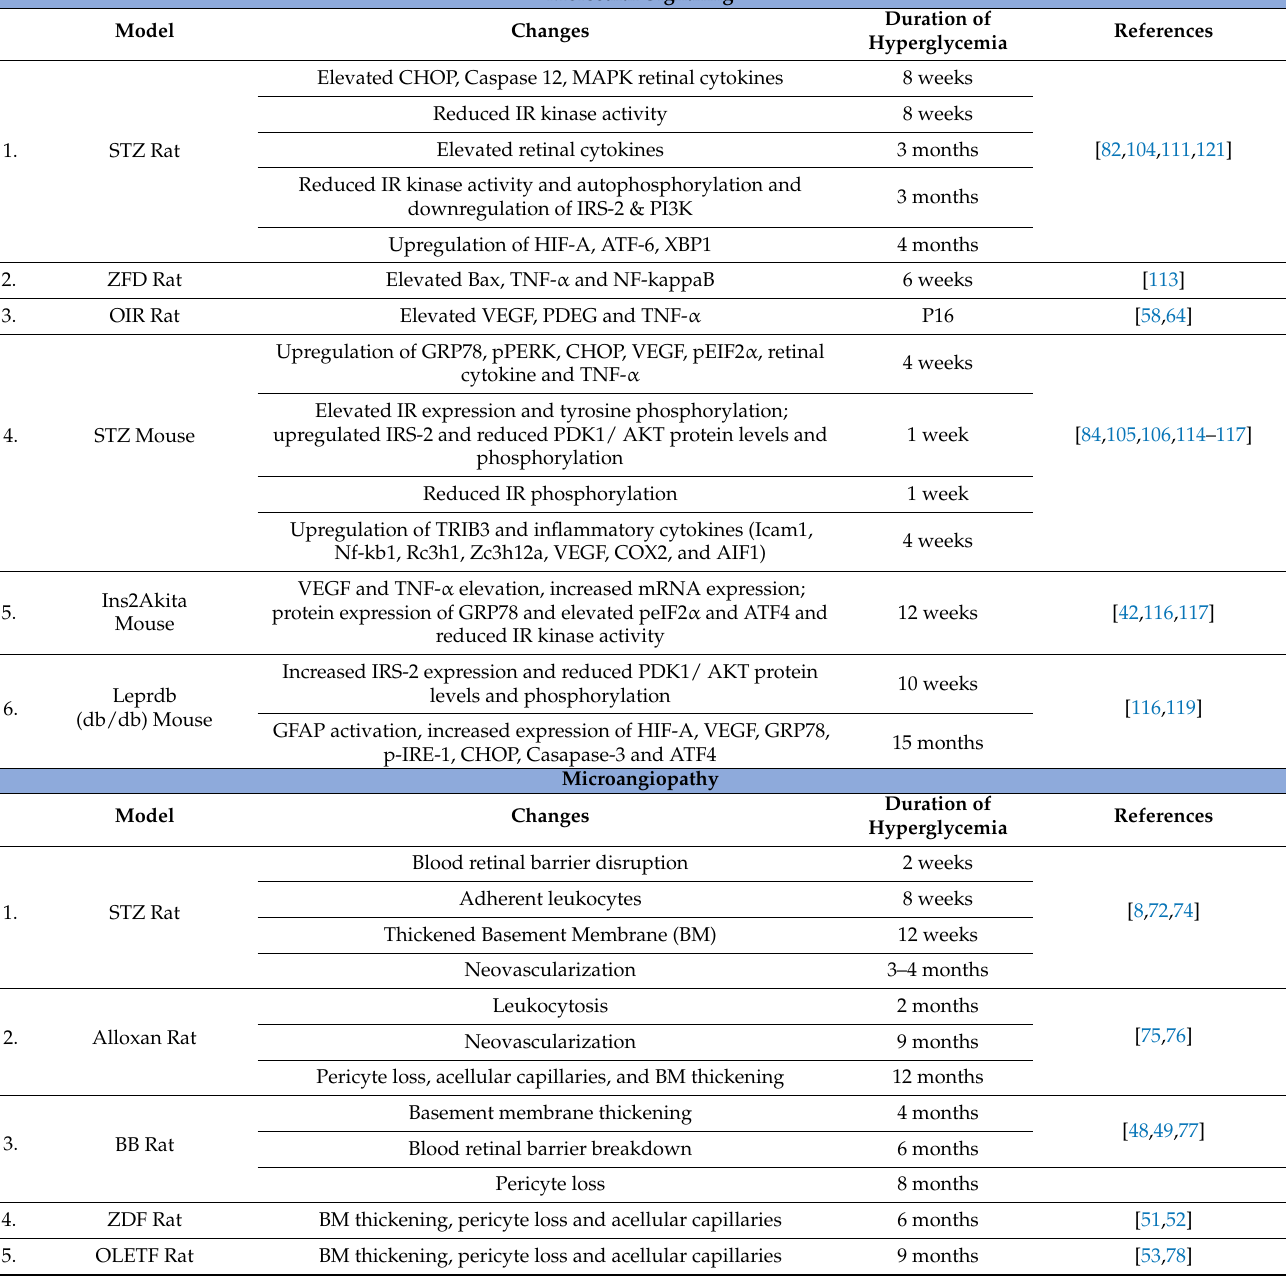
Table 2. Cellular signaling, loss of retinal function and integrity in rodent models of diabetic